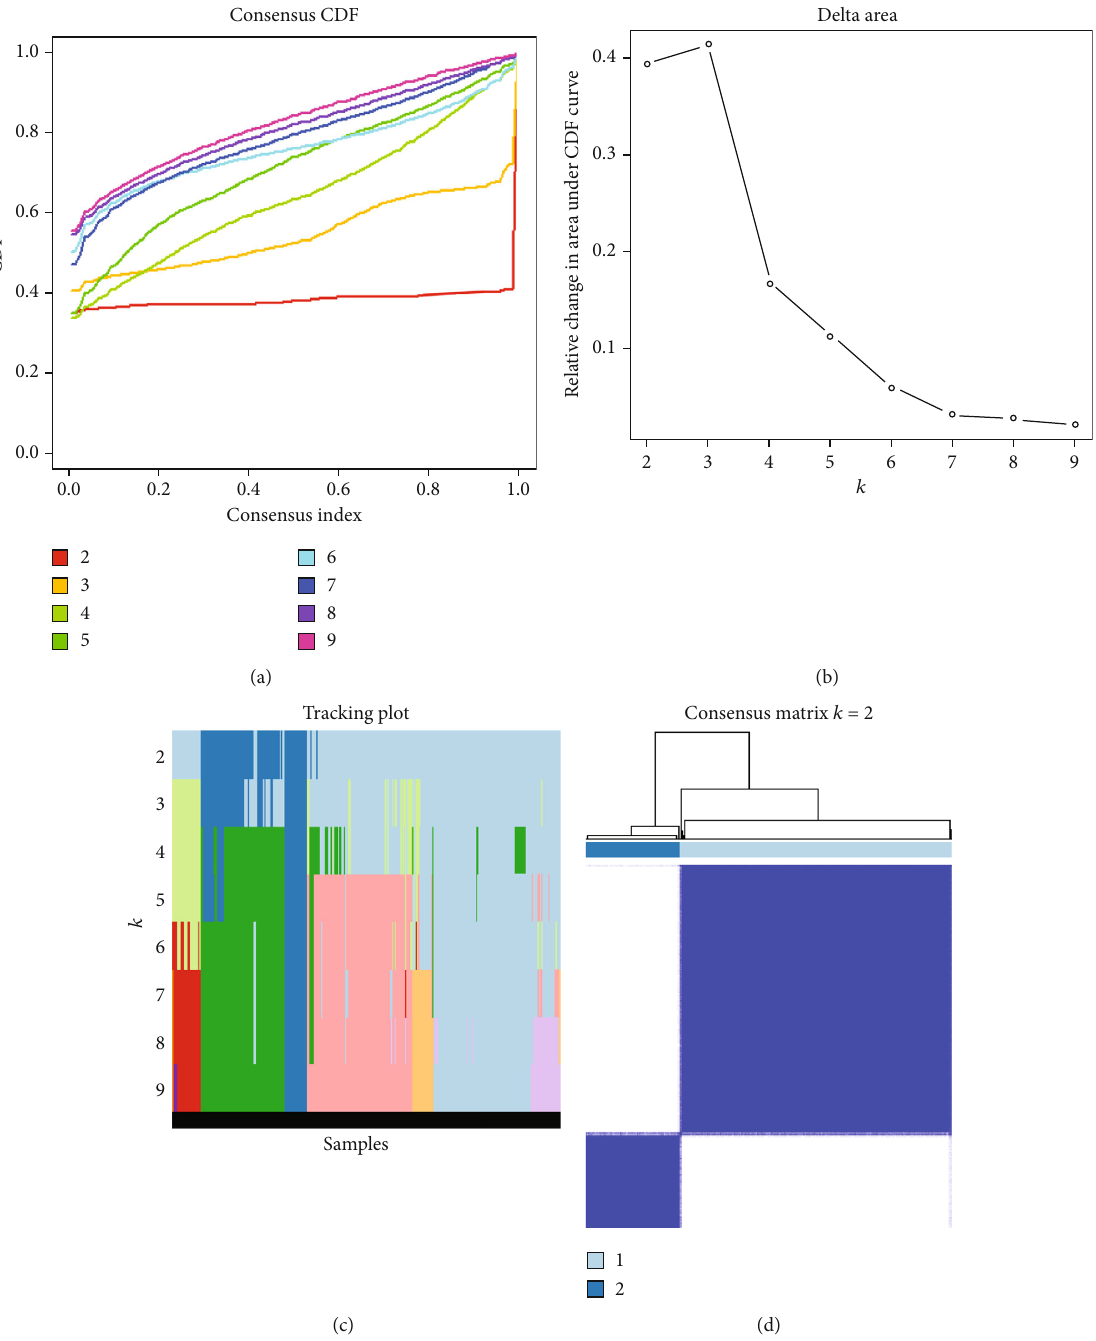
Figure 3: Consensus clustering on the uterine corpus endometrial carcinoma The Cancer Genome Atlas cohort according to the expression of 36 prognostic m6A-relevant lncRNAs. (a) Consensus clustering distribution function (CDF) for k = 2 -9. (b) Increment in the area under the CDF curve for k = 2 -9. (c) Tracking plot for k = 2 -9. (d) Consensus matrix for the optimal value, i.e., k = 2